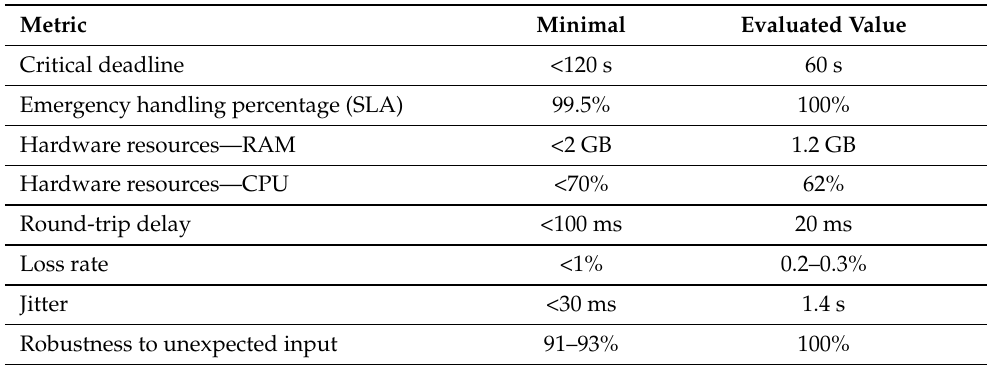
Figure 10. Jitter evaluation for caller RTCP packets (green) and called-entity RTCP packets (blue). Table 4. Summary of efficiency